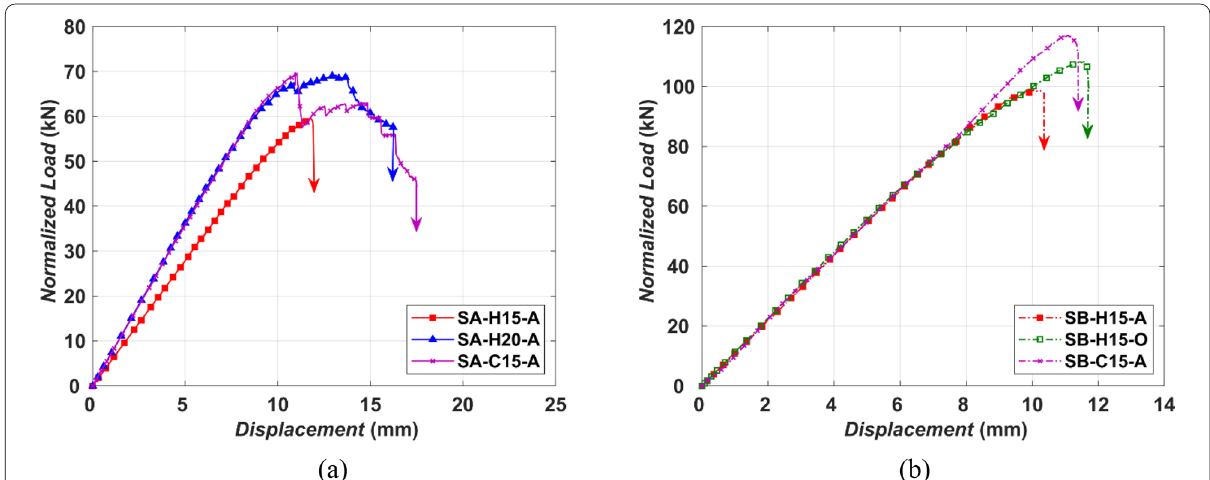
Fig. 13 Load–deflection curves of specimens with different strengthening sheet types in Group a SA; b